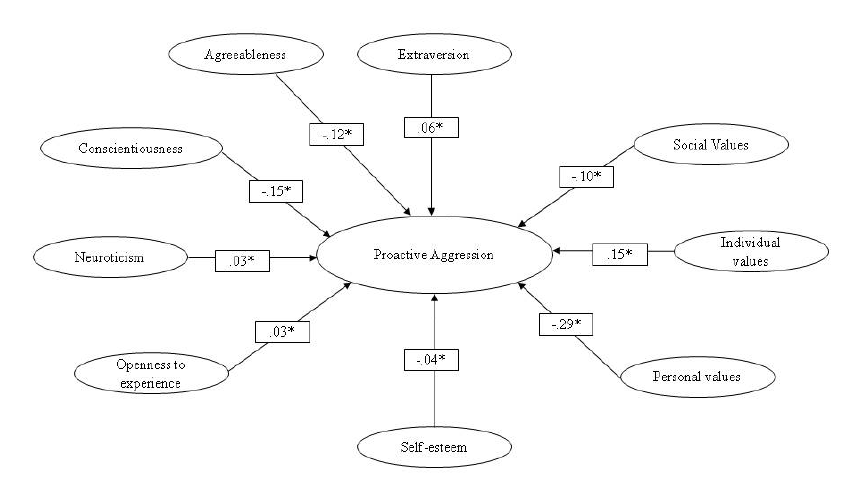
Figure 1. Structural equation model for proactive aggression (non-involvement) using personality, values and self-esteem